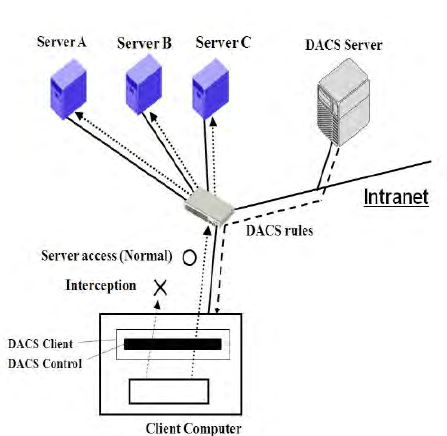
Figure 4 Basic Principle of the DACS Scheme